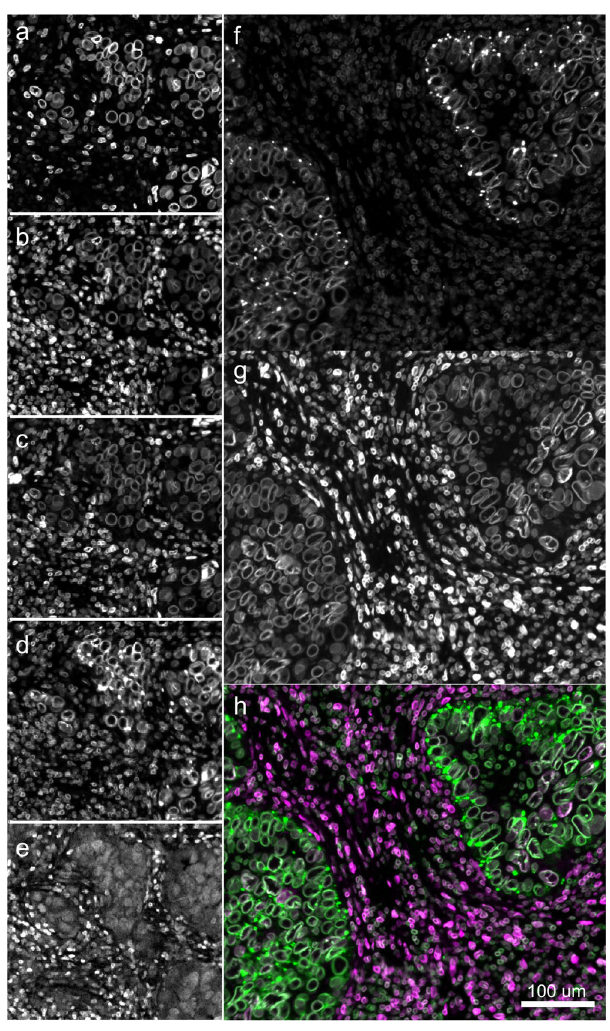
Fig. 2 Comparing different nuclear envelope stains in colon adenocarcinoma. Showcasing a lamin A/C, b lamin B1, c lamin B2, d NUP98, and e the lamin B receptor in the same fi eld of view. Lamin B1 and B2 appear to stain similar proportions of nuclei while lamin A/C stains fewer nuclei. The stain against the lamin B receptor was comparatively weaker. Lamin B2 ( f ) and NUP98 ( g ) are complementary and, when used in combination, maximize the number of cells stained. h Composite of lamin B2 (purple) and NUP98 (green). Scale bar denotes 100 μ